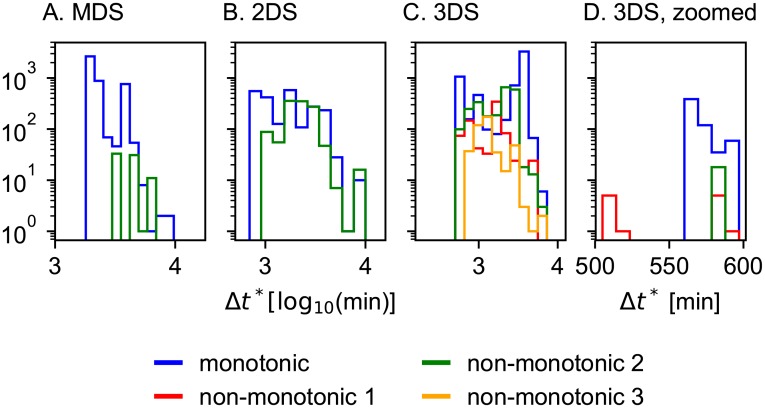
Distribution of induction times for the different toy models.For the MDS and 2DS no bistable non-monotonic type 1 solutions were found. For the 3DS many bistable solutions are found and the lowest inductions times are found for non-monotonic type 1 as we expected (panel D). Non-monotonic responses are not in general faster than monotonic responses (panel C): the induction time depends on the actual shape of the response curve and therefore on the parameters.